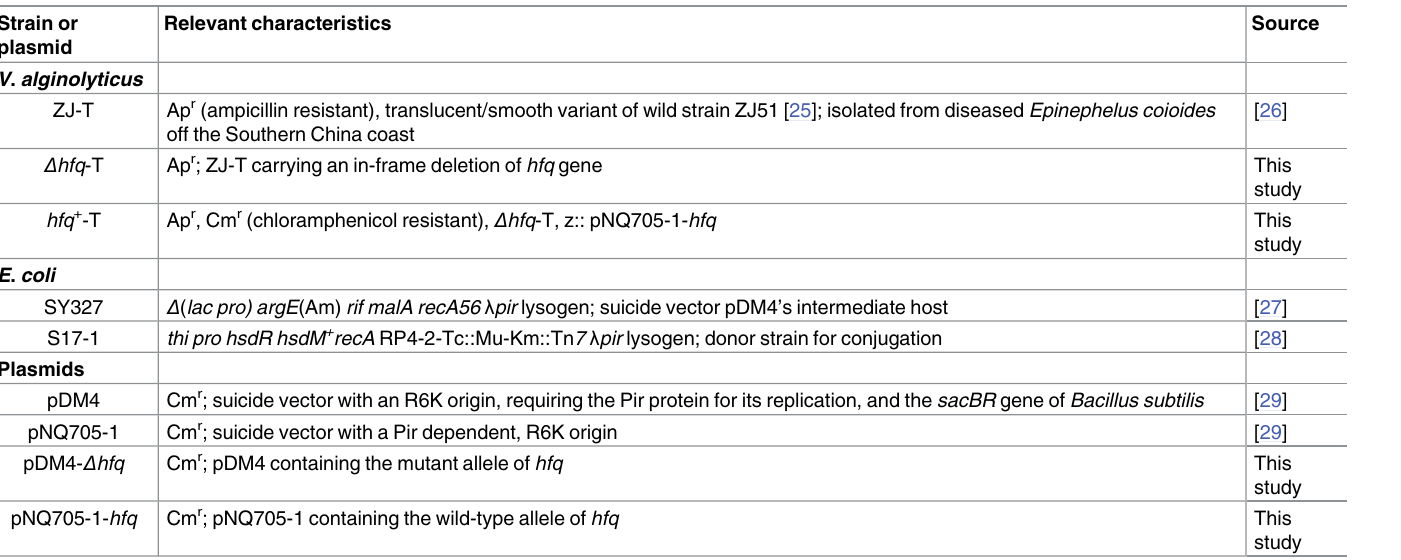
used. Unless otherwiseindicated, M63 minimum medium was made according to the following recipe: 3 g.L -1 KH